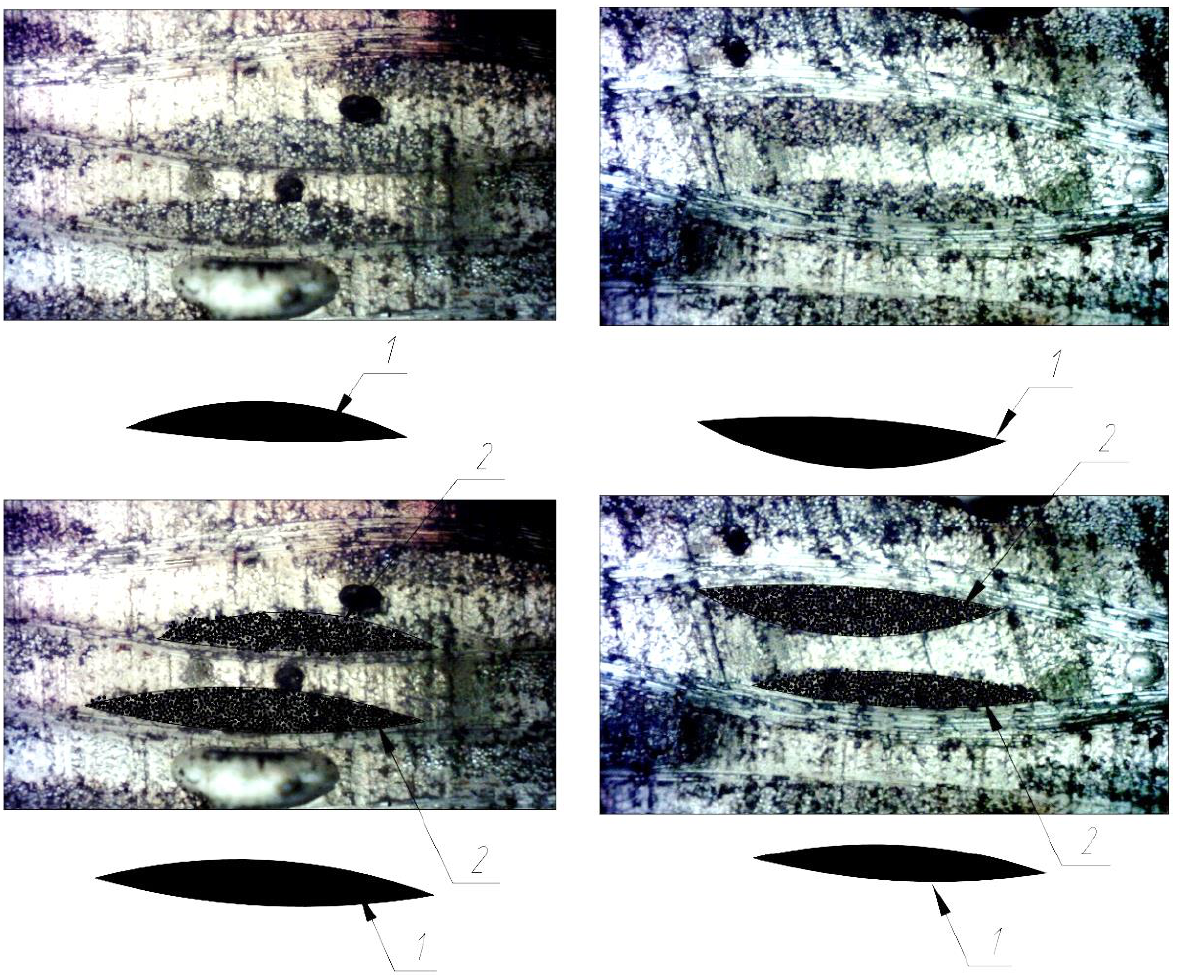
Figure 6. Microphotograph of a fragment of the sample cross-section: (1) highlighted “gross” area of the longitudinal yarn; (2) approximate distribution of fibers inside the yarn.